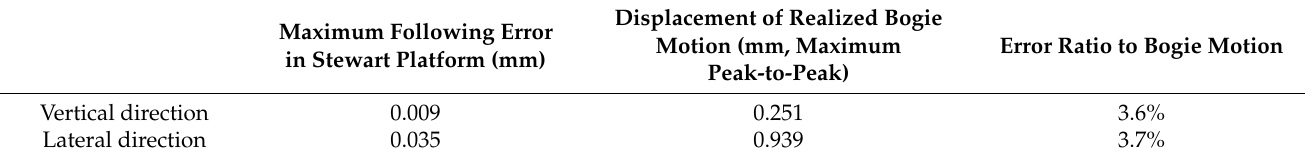
( b ) Figure 5. Stewart platform displacement measurement obtained using laser displacement-measuring sensor: ( a ) vertical